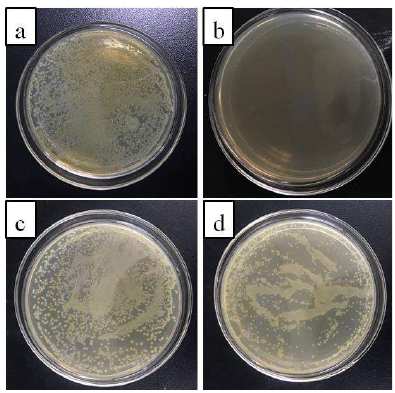
Figure 8. Optical images of agar plates characteristic of the antimicrobial activities of the control group ( a ), eugenol ( b ), hydrogenterminated siloxane ( c ) and bio-phenol siloxane ( d ).